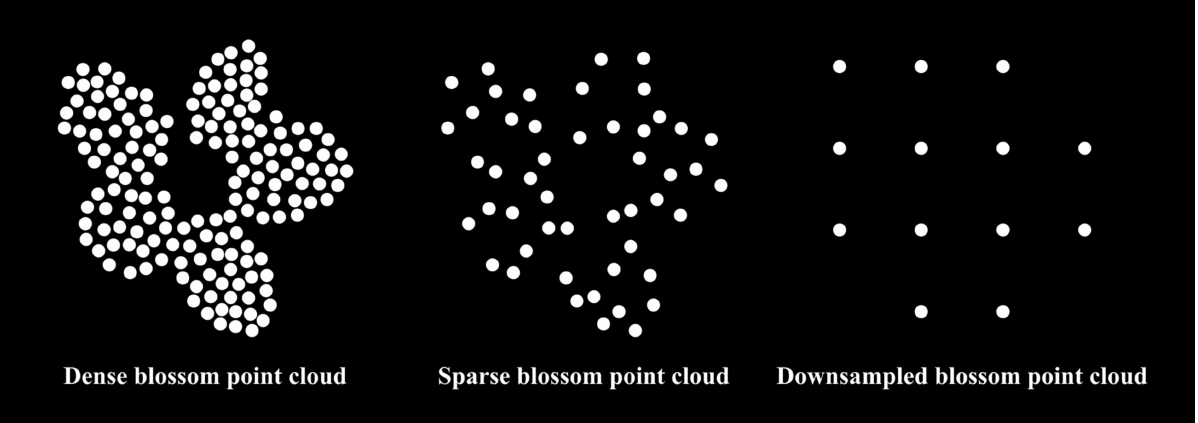
Figure A7. Graphic illustration showing densely and sparsely reconstructed point clouds of the same apple blossom being downsampled to the same number of points.